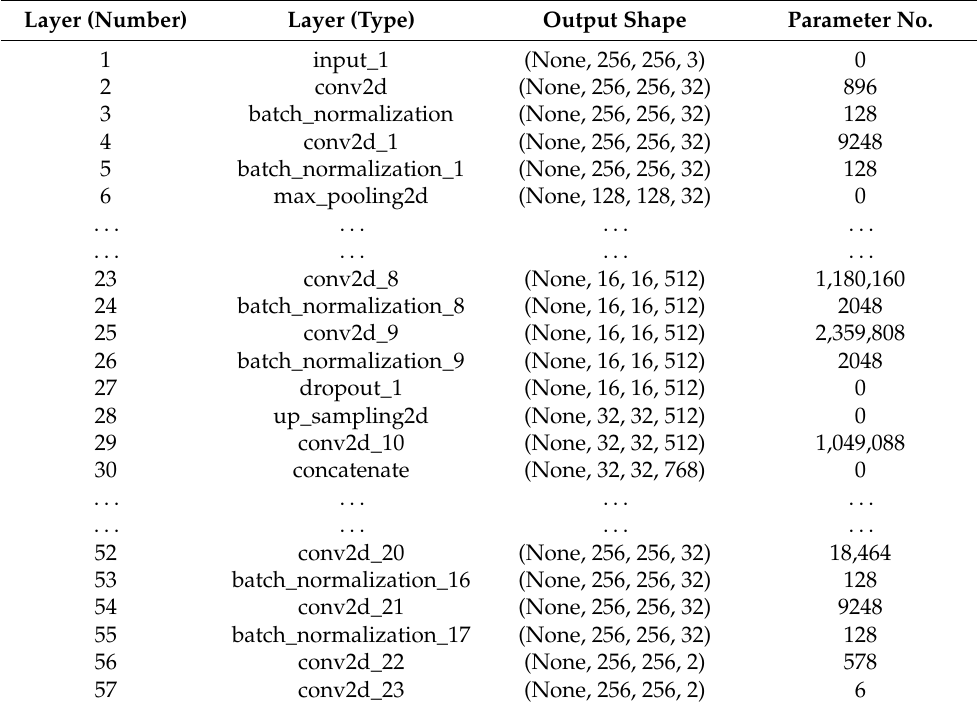
Table 3. The structure and number of parameters of the